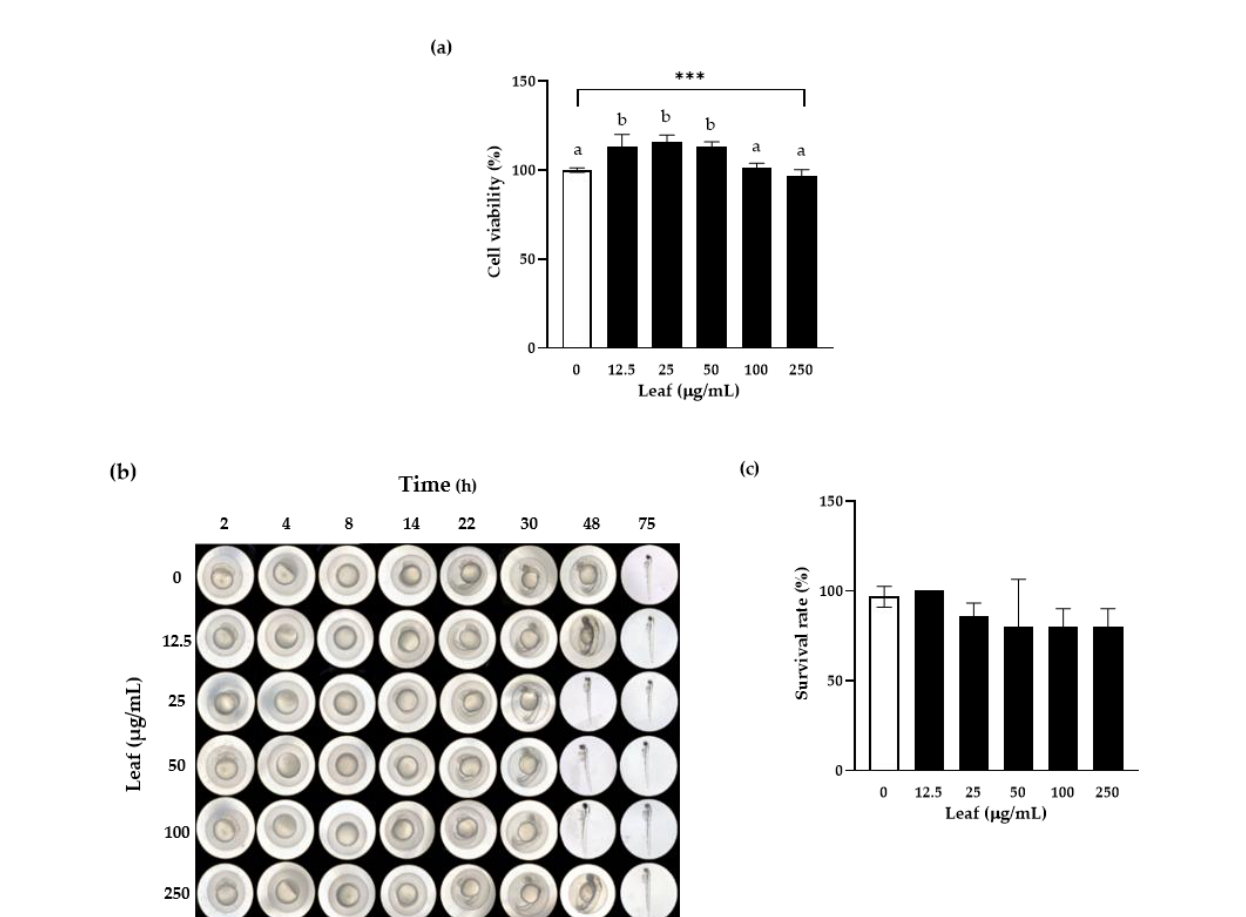
Figure 2. Effect of LL on cell viability in vitro and in vivo. Caco-2 cells were treated with the indicated concentrations of LL for 24 h, and the cell viability was measured using a WST assay ( a ). Zebrafish eggs were incubated with the different concentrations of LL in the egg water for up to 75 h, and photographs were taken ( b ). The survival rates of zebrafish eggs were calculated by counting the hatched eggs for 72 h ( c ). The white bar represents negative control set as 100%. Data are shown as the means ± SD of at least three independent experiments. Significant differences between different concentrations were analyzed using Duncan’s multiple range test with one-way ANOVA and values labeled with different letters are significantly different ( p < 0.05). Significant different value compared to the control group was analyzed using a student’s t-test. *** p < 0.001. LL: Lycium barbarum leaf.